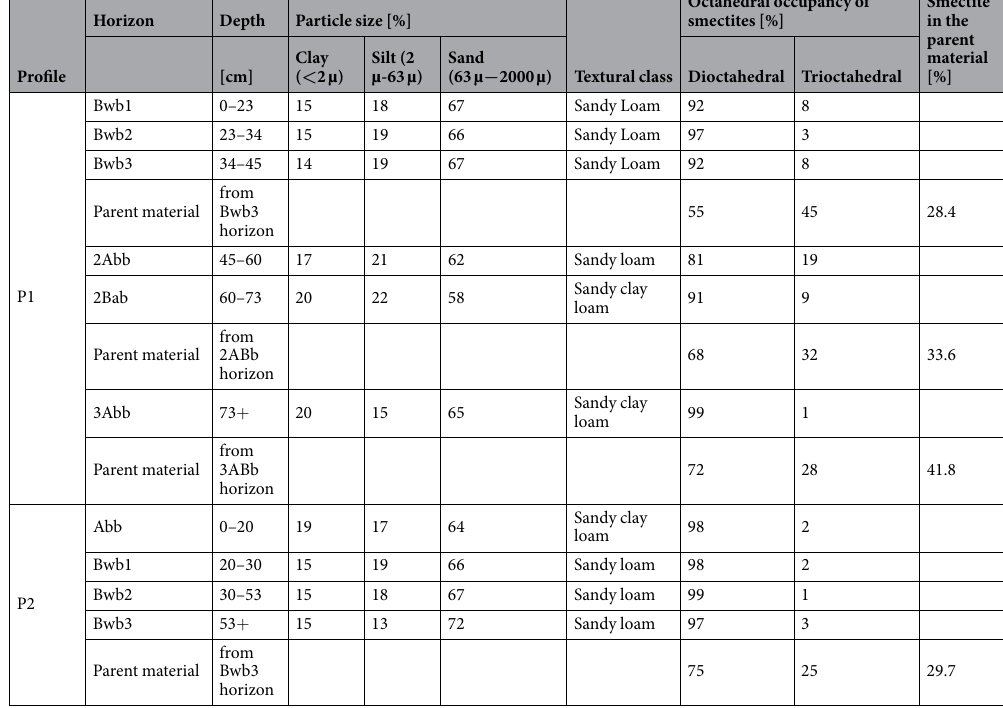
Table 1. Grain-size distribution, textural classes and smectite properties and proportion.